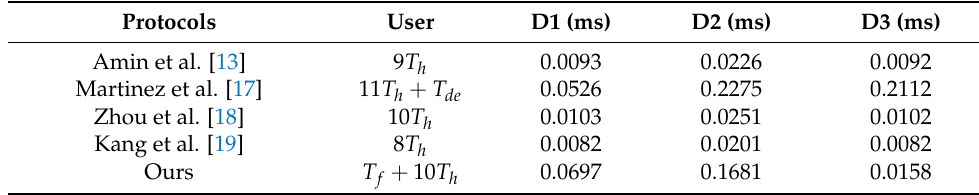
Table 5. Comparative results of user computational